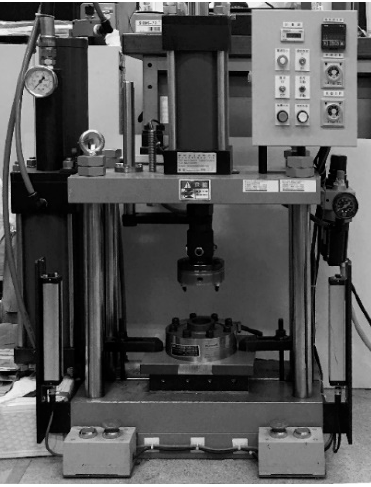
Figure 3. A hydro-pneumatic press machine, ARC-10 T, made by APMATIC Corp, Taiwan [26].